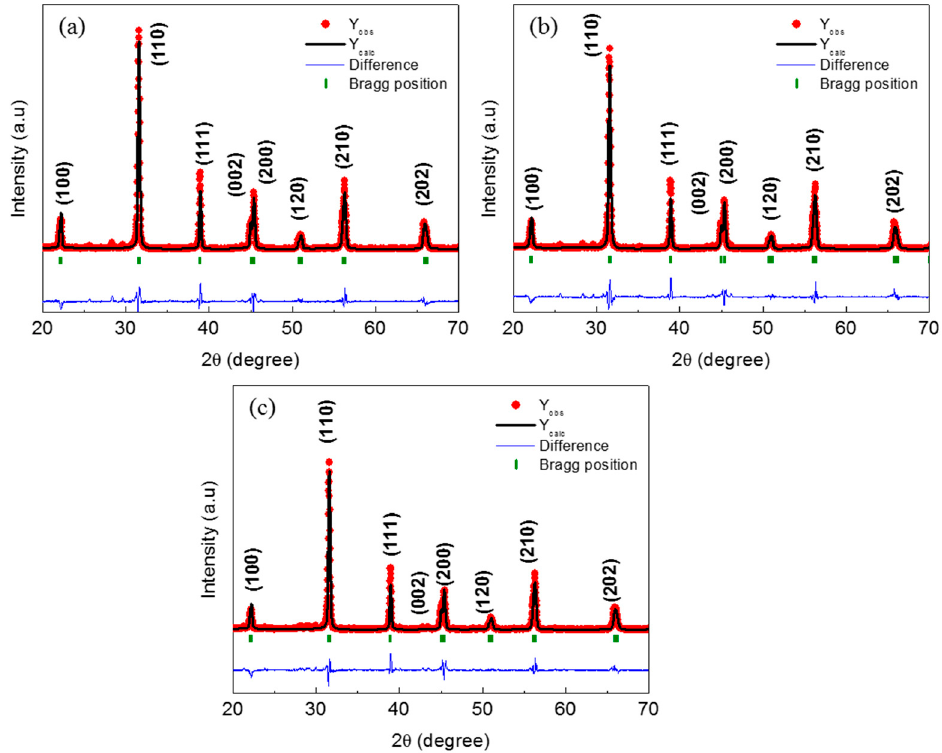
Figure 2. Powder X-ray diffraction powders for the BaTiO 3 ceramics sintered at ( a ) 1100 ◦ C, Figure 2. Powder X ‐ ray diffraction powders for the BaTiO 3 ceramics sintered at ( a ) 1100 °C, ( b ) 1200 ( b ) 1200 ◦ C, and ( c ) 1300 ◦ °C, and ( c ) 1300 °C.